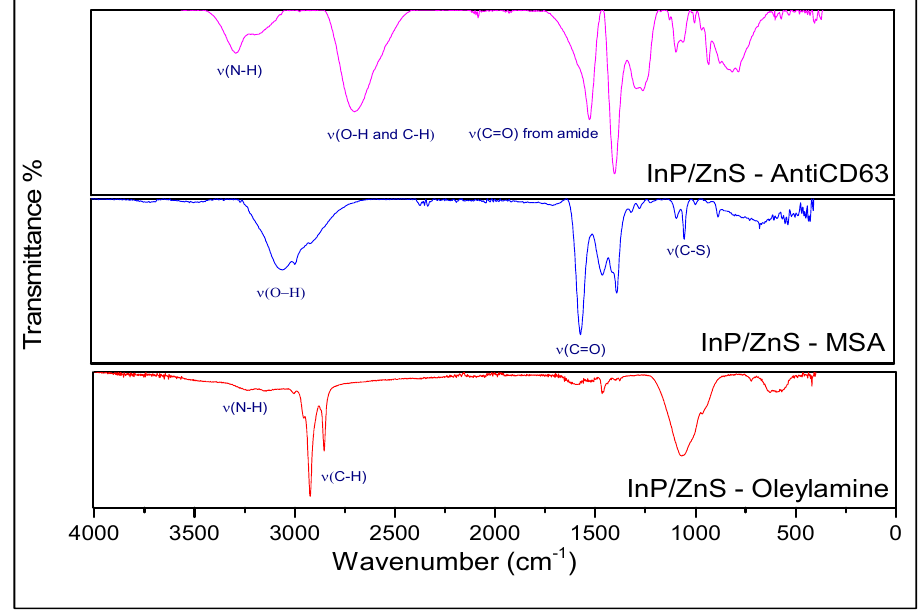
Figure 3. Fourier transform infrared spectroscopy (FTIR) spectra of the InP/ZnS–oleylamine, InP/ZnS–MSA, and InP/ZnS–Anti-CD63.